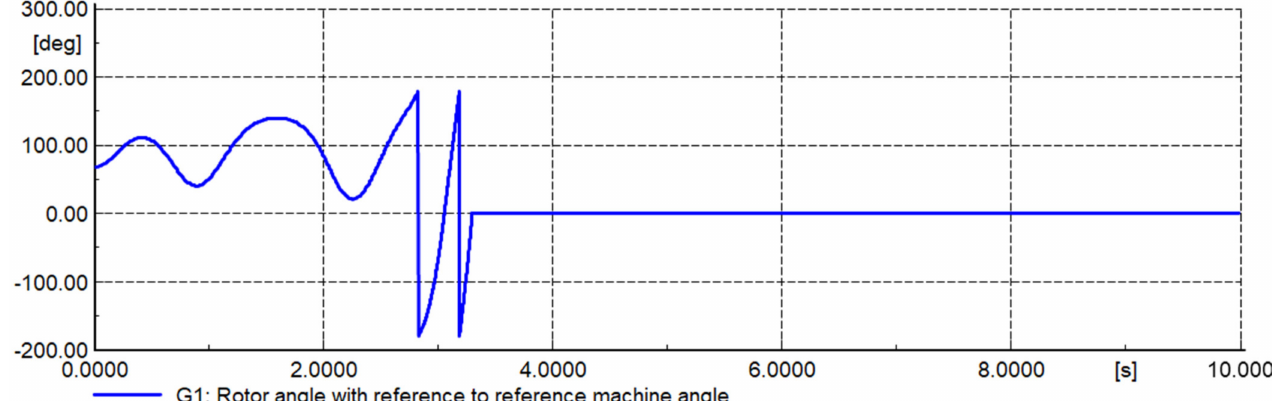
Figure 15. Test 1 : Rotor angle of G1 generator behaviour with OOS protection on CCT-1 line.